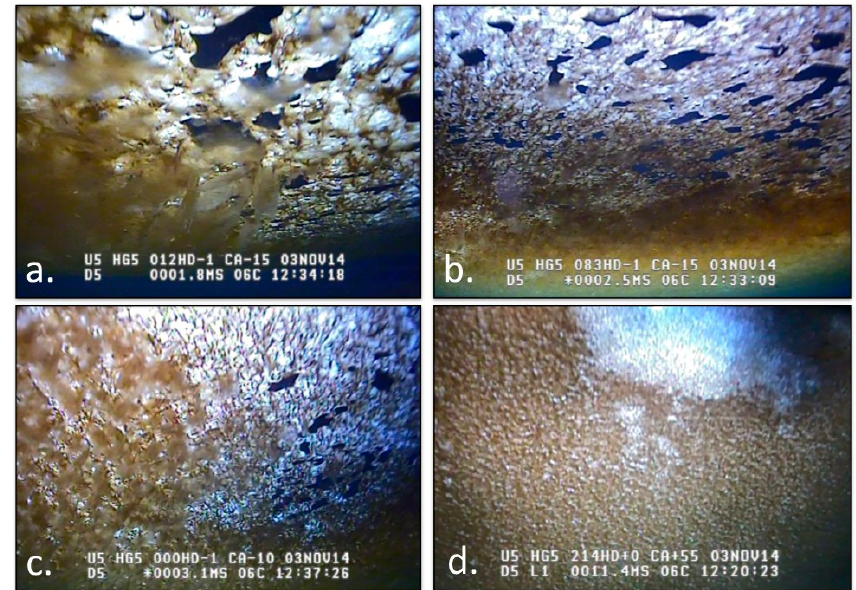
Figure 12. Example of the fine-scale ice textures identified in the ROV imagery; ( a ) boundary of platelet ice and smooth ice (close up); ( b ) smooth ice and platelet ice boundary from oblique view; ( c ) bottom-up view of platelet and smooth ice boundary; and ( d ) broadscale view of platelet and smooth ice.